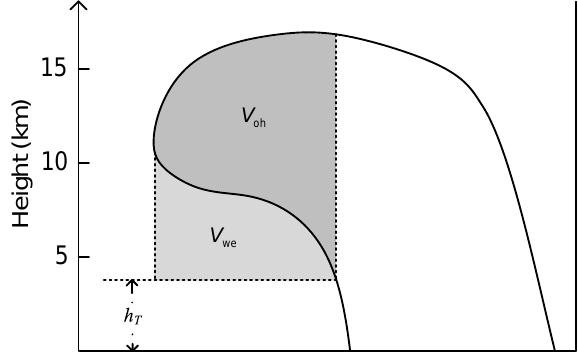
Figure 8. Schematic diagram of two volumes V we and V oh in cross-section view.